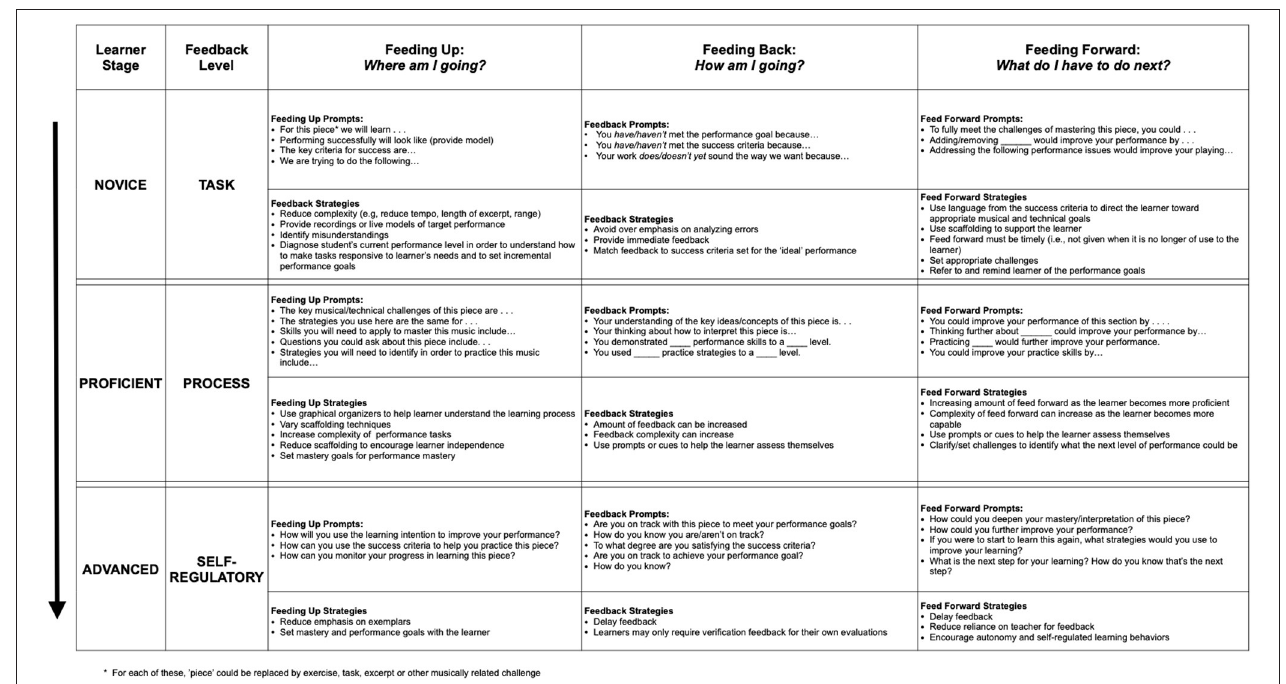
FIGURE 3 | A matrix of feedback for learning. Adapted for music performance teaching from Brooks et al. (2019a, p. 28).